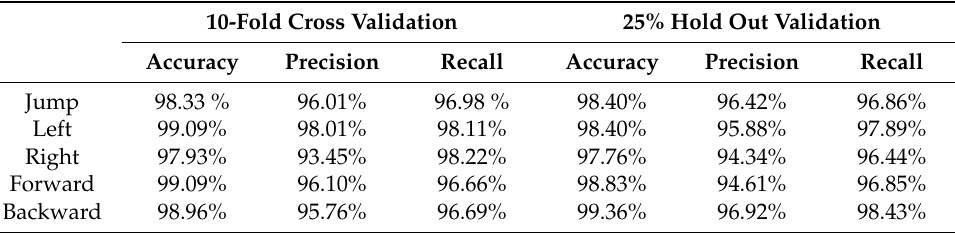
Table 6. Evaluation of SVM classifier.